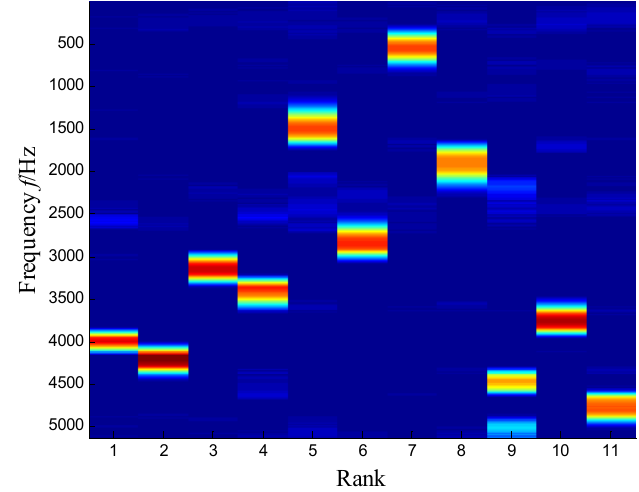
Figure 29. Coefficient matrix heat map of SKNMF.